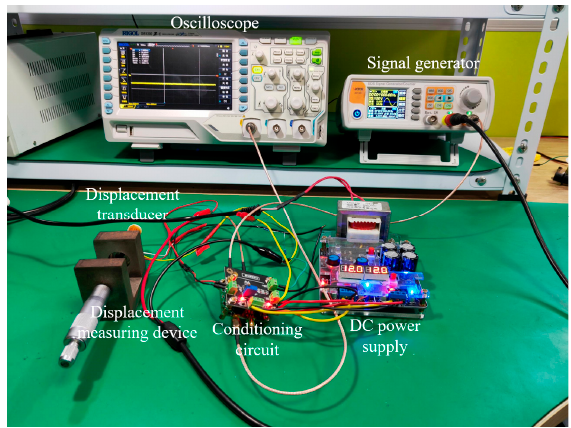
Figure 12. Test circuit.